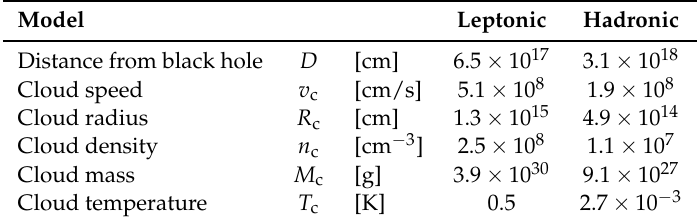
Table 1. Inferred cloud parameters from the leptonic and hadronic modeling shown in Figures 3 and 4.